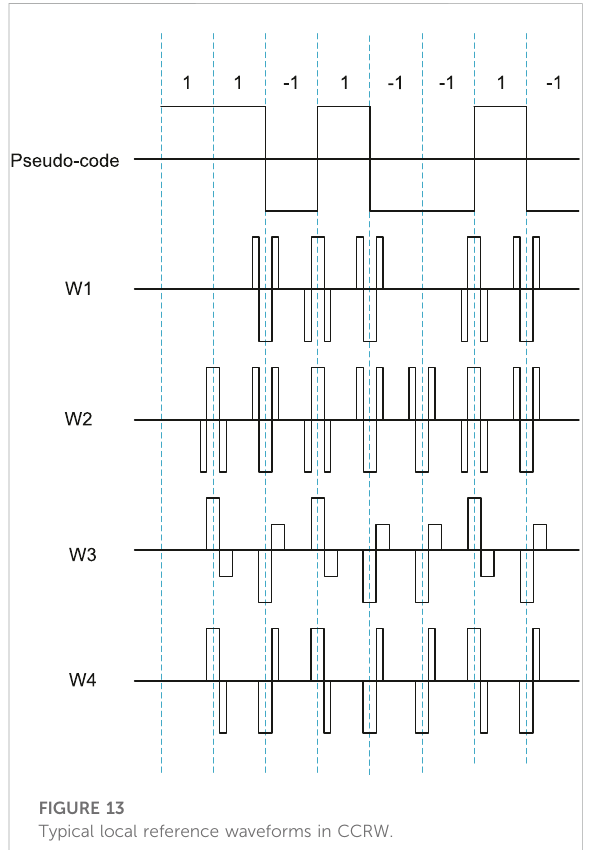
FIGURE 13 Typical local reference waveforms in